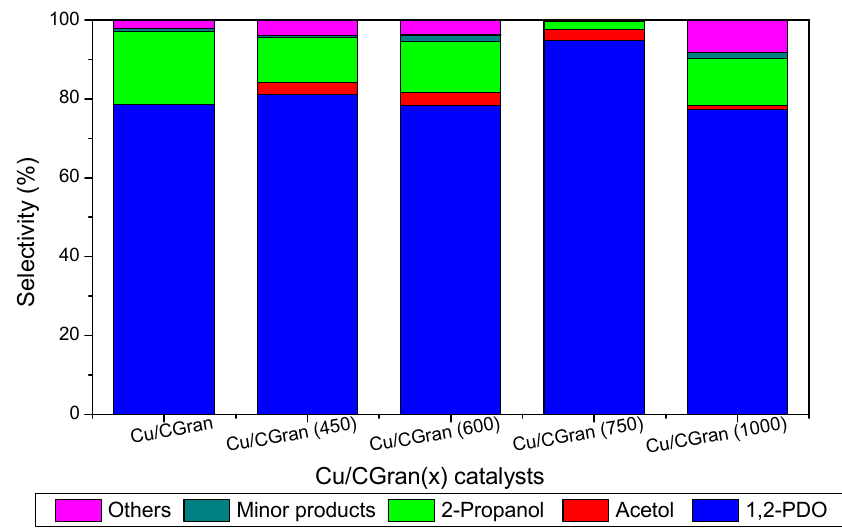
Figure 8. Product distribution calculated at final conversion of glycerol on Cu / CGran and Cu / CGran(x) catalysts.